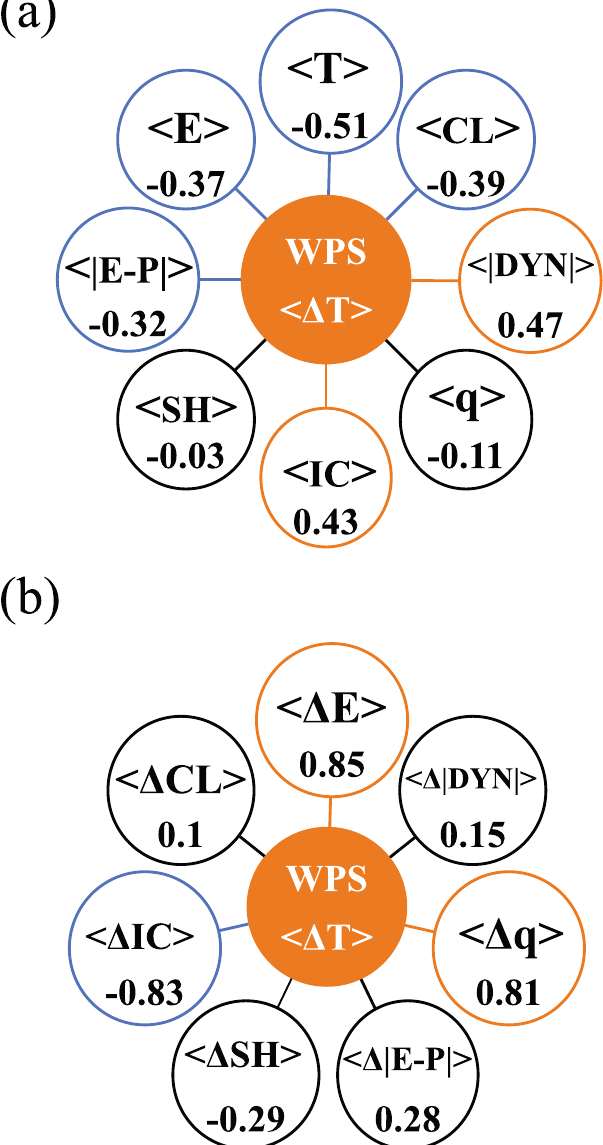
Figure 2. Correlation coefficients between the warming projection spread (WPS) and ( a ) spreads in the eight key control climate state variables, ( b ) spreads in the key climate variable transient responses to 4xCO 2 . Numbers in orange and blue colored (black) circles indicate the correlation coefficients (do not) exceed 90% confidence